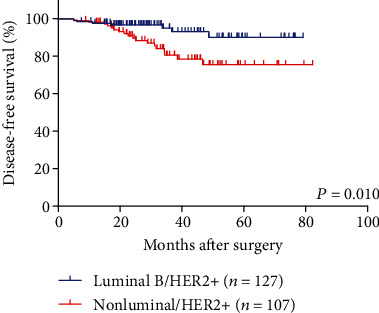
DFS curves in luminal B/HER2+ and nonluminal B/HER2+ patients.